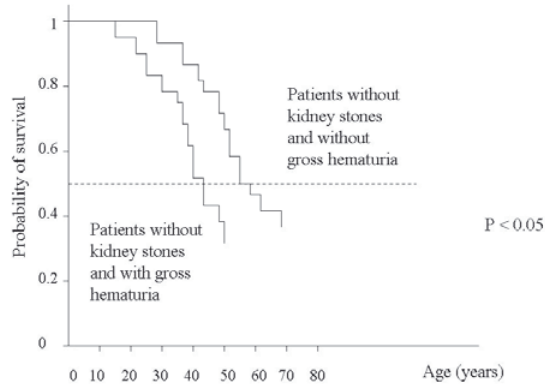
Figure 4. Comparison of renal survival between patients without kidney stones and with and without gross